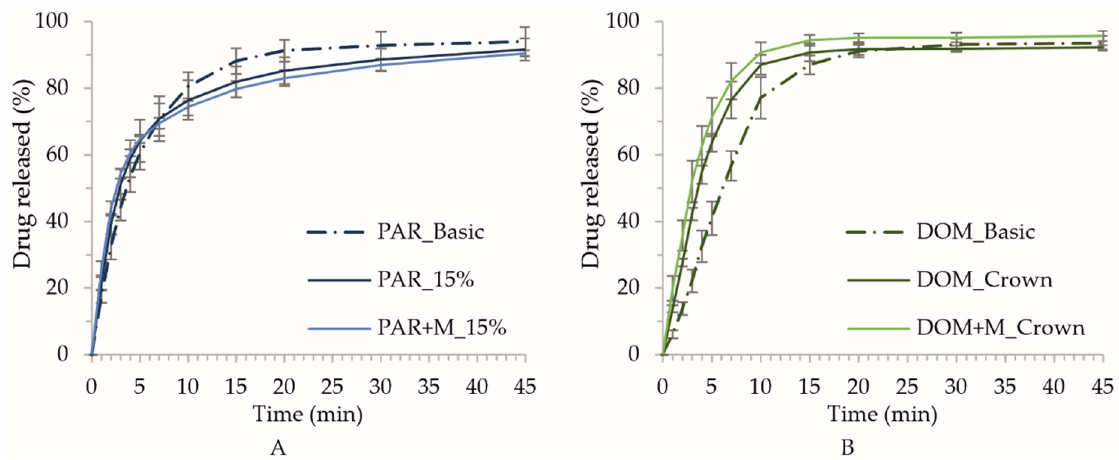
Figure 10. Dissolution profiles of paracetamol ( A ) and domperidone ( B ) from 3DP tablets.